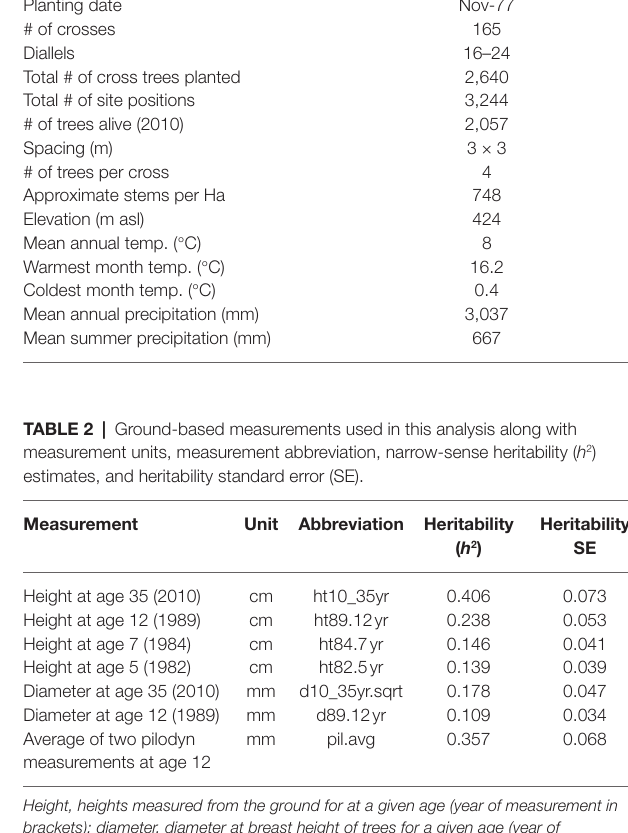
Height, heights measured from the ground for at a given age (year of measurement in brackets); diameter, diameter at breast height of trees for a given age (year of measurement in brackets); and pilodyn, wood density